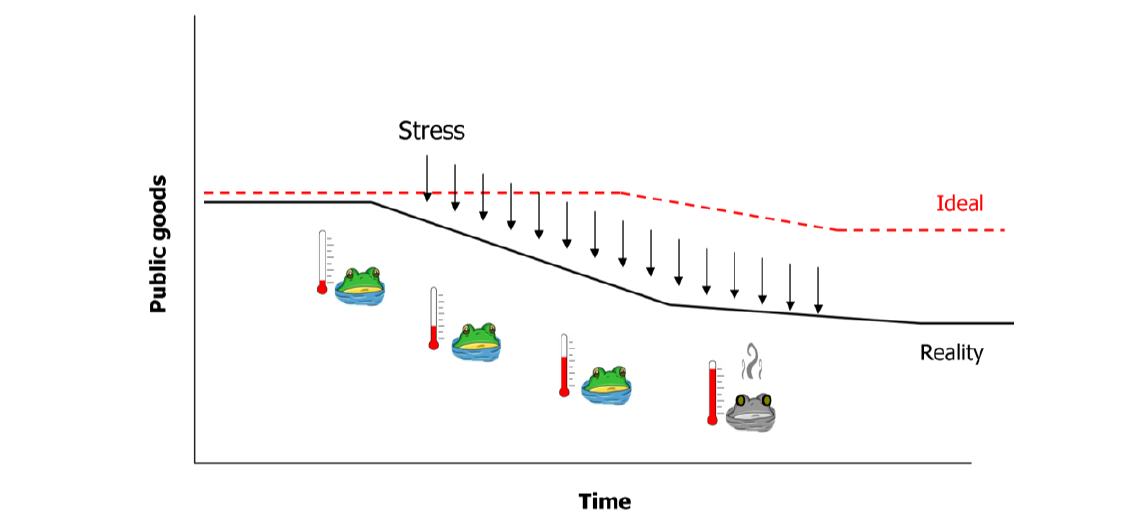
Figure 8. Unperceived stresses and eroding public